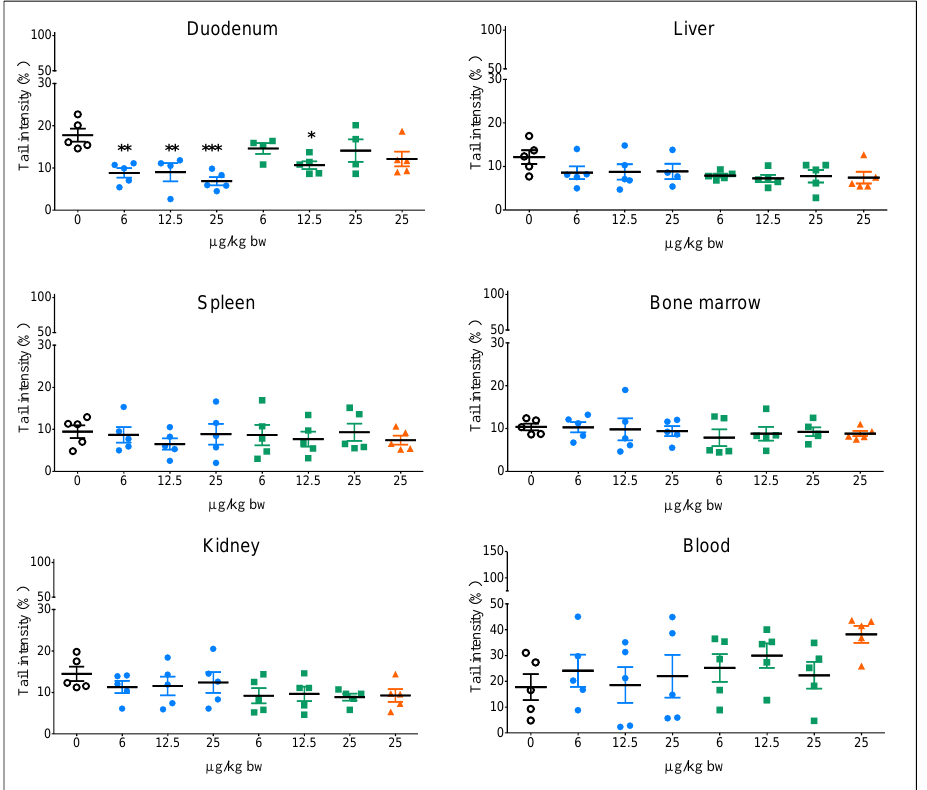
Figure 2. Oxidative DNA damage in different organs/tissues of rats orally exposed to Al 0 NMs, Al 2 O 3 NMs or AlCl 3 . A group treated with the vehicle (0, negative control) was included. Significant from control at * p < 0.05, ** p < 0.01, *** p < 0.001.